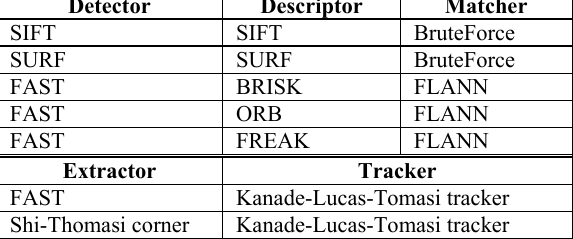
Table 1. The corresponding points extraction methods